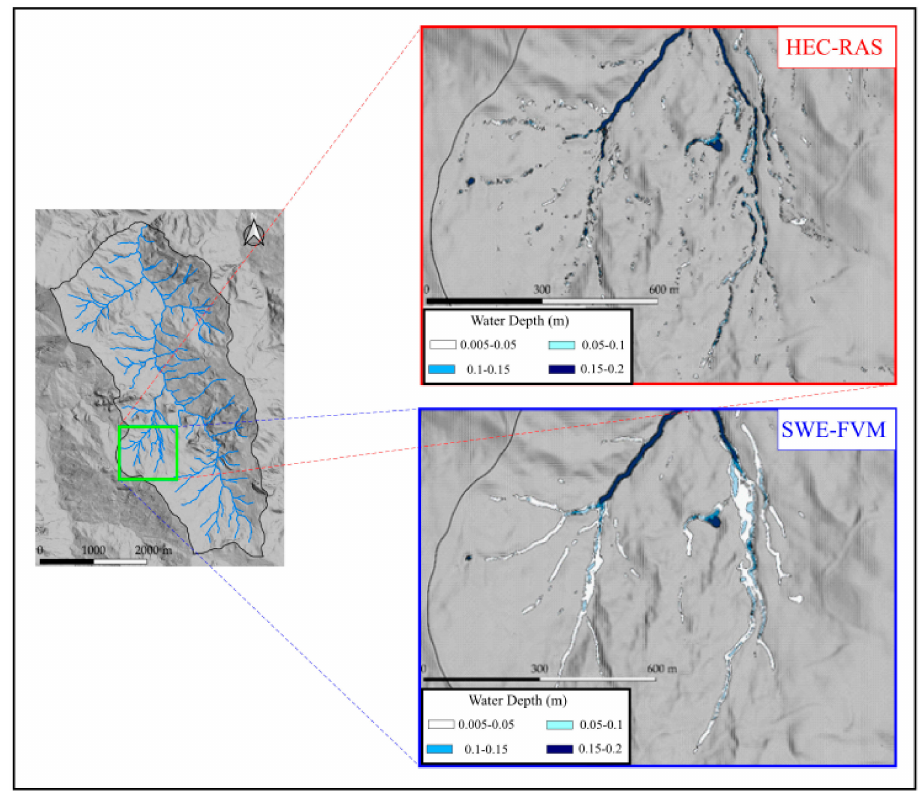
Figure 8. Detail of the flooded areas computed by HEC-RAS and SWE-FVM for water depth threshold equal to 0.05 m, considering T = 200 years and grid size 5